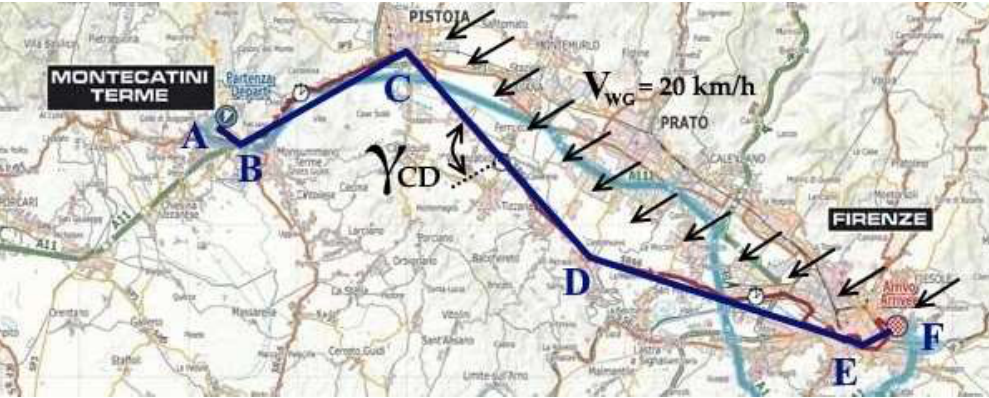
Figure 4. Route map of the time race simulation: the blue path simplifies the red-coloured real